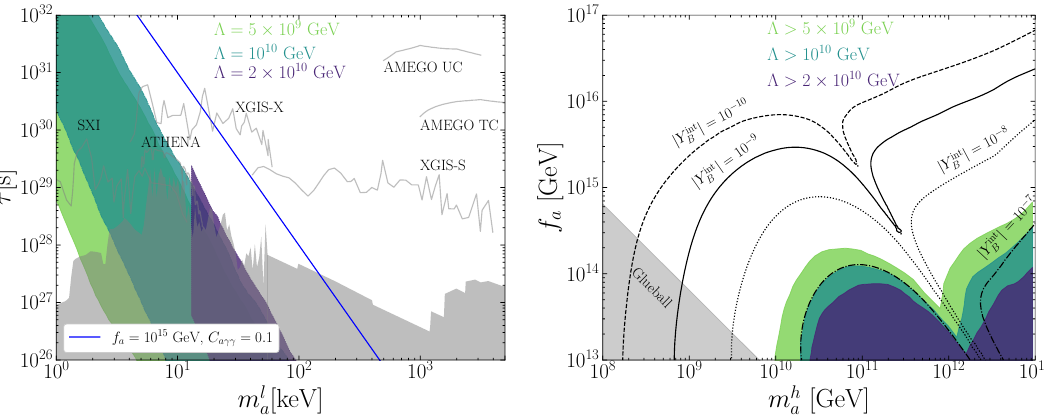
Figure 3 . (Left) As in figure 1 but for the case where there is both a keV–MeV axion, illustrated in the left panel, that explains the primordial DM and a much heavier axion, illustrated in the right panel, that explains the primordial baryon asymmetry through spontaneous baryogenesis. We illustrate lifetimes and masses where these two abundances are correctly reproduced for fixed values of the intermediate scale Λ . Note that unlike in figure 1 the Λ are taken to be well below the GUT scale, which is necessary to avoid over-diluting the baryon abundance. As in figure 1 we allow | θ l | > 0 . 01 and 0 . 05 < | C aγγ | < 1 while requiring T RH > 5 MeV. (Right) The heavy axion parameter i space in the two-axion model, illustrated by the heavy axion mass and its decay constant. Shaded regions show where the two primordial abundances are correctly produced for Λ greater than the indicated values. The Y int contours show how much ‘intermediate’ baryon asymmetry is produced B before the entropy dilution through glueball domination and reheating of the DM dark sector (i.e., the dark sector with the lower confining scale). These contours are the same as in figure 2. In this case we must overproduce the baryon asymmetry at intermediate scales, since the period of early matter domination, which is necessary to achieve the correct DM abundance, dilutes the baryon